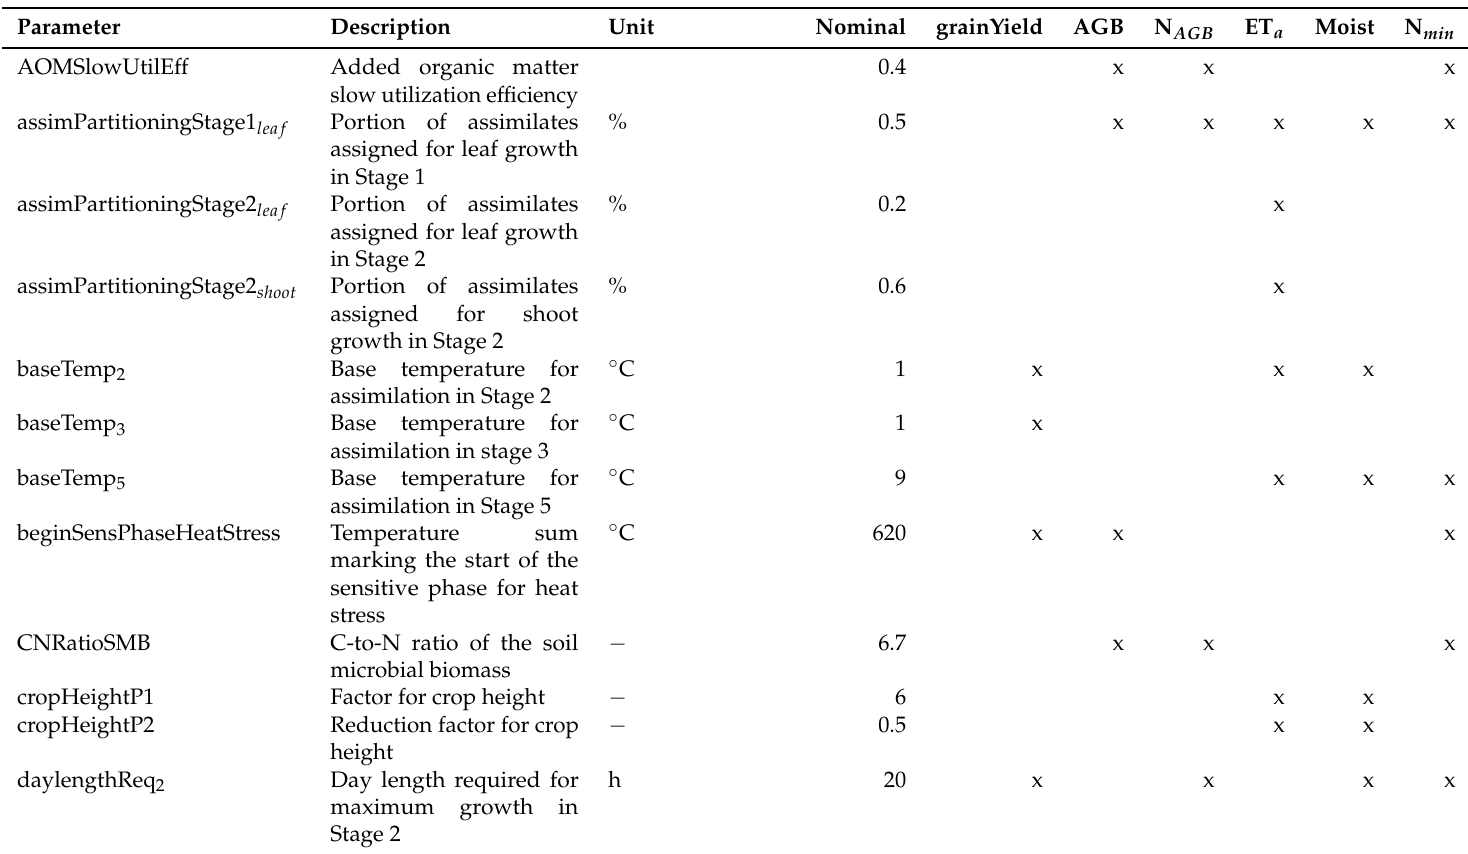
Table 3. Relevant model parameters as identified using the time-dependent Morris approach with τ t = 0.8. A parameter was marked as relevant if its µ ∗ ( t ) was higher than the threshold value τ t in one of the investigated